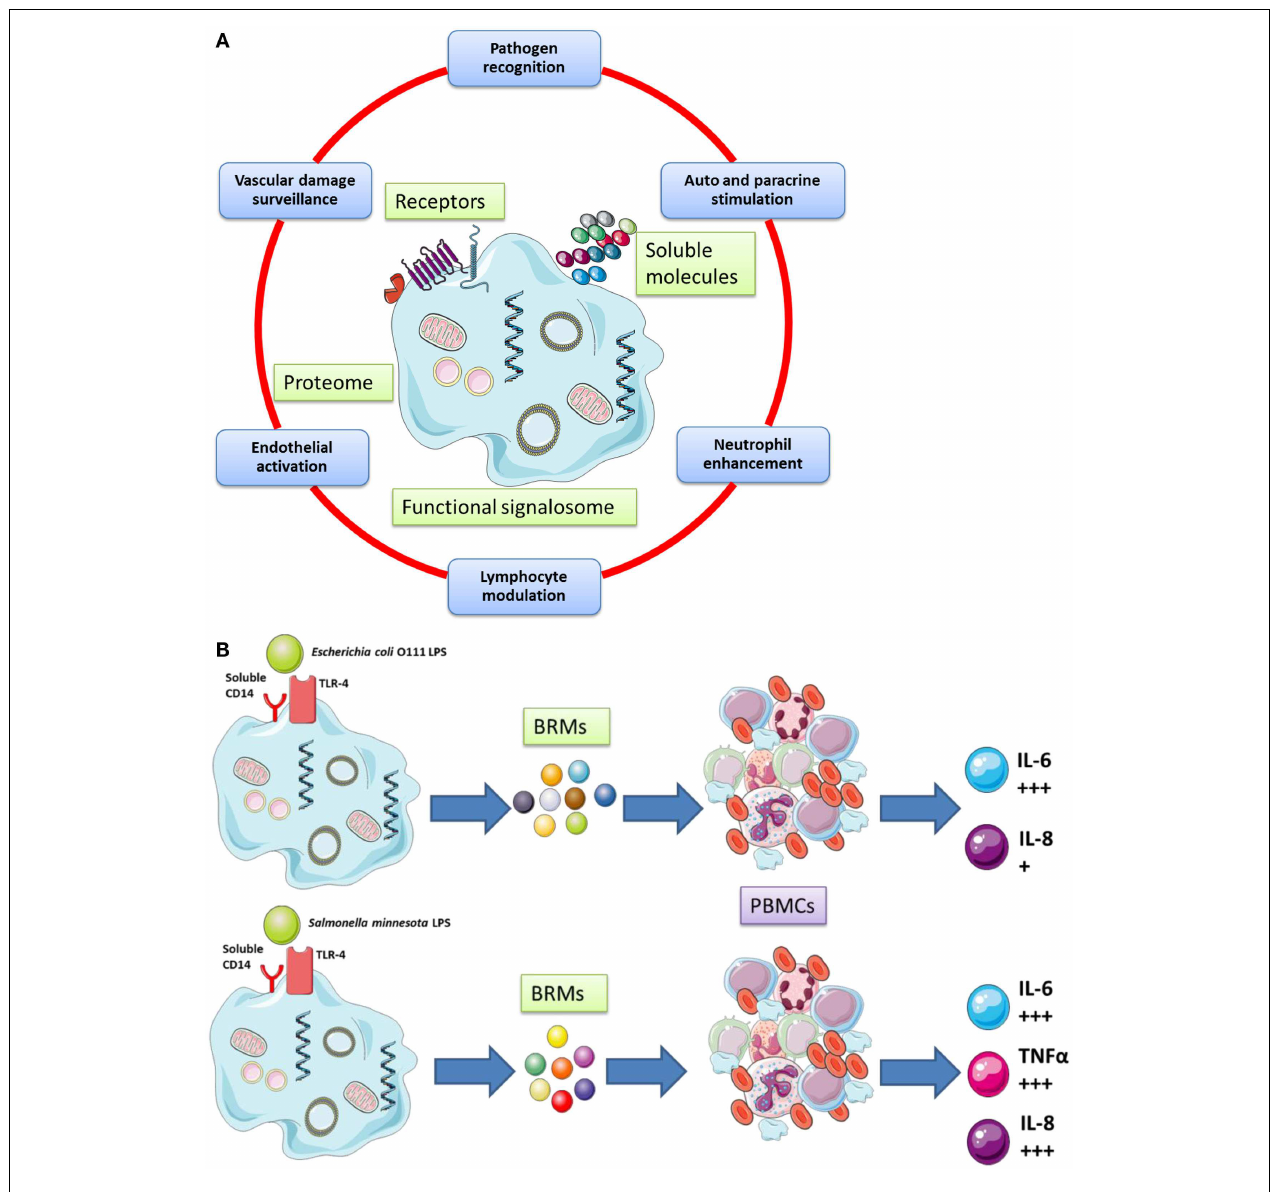
and proliferative events and play a critical role for tissue remodeling and wound healing. (B) Human platelets can discriminate between various bacterial LPS isoforms viaTLR4 signaling and differential cytokines secretion [adapted from Berthet et al. (54) and Hamzeh-Cognasse et al.